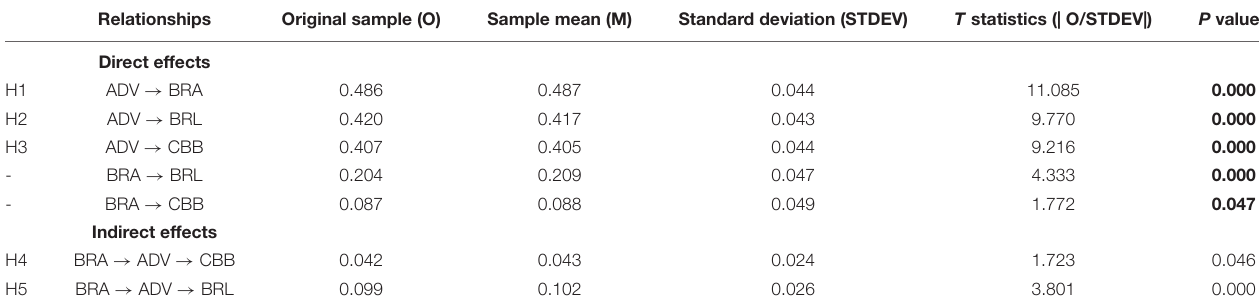
TABLE 7 | Structural model path coefficients.